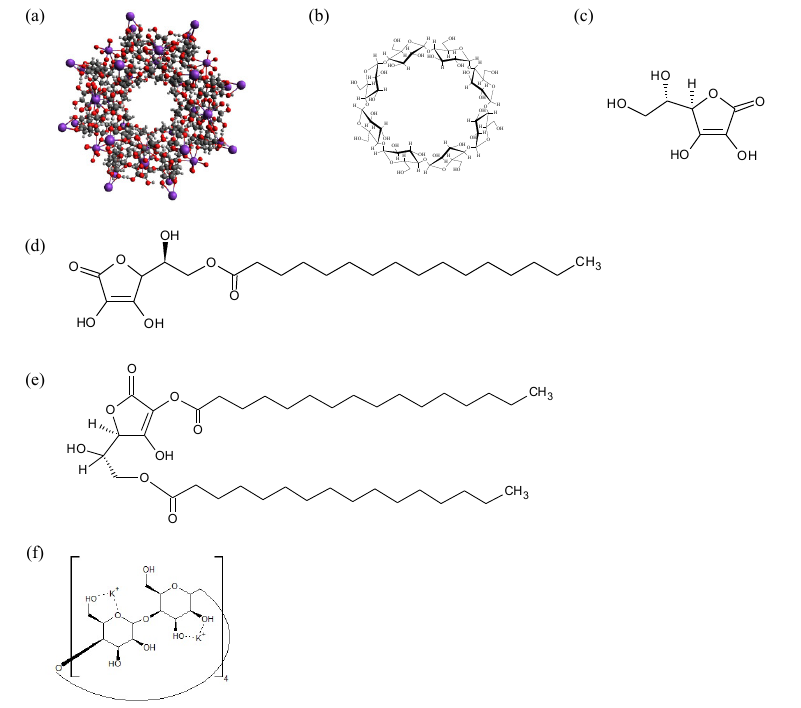
Figure 1. Chemical structures of: ( a ) CD-MOF-1; ( b ) γ -CD; ( c ) ASC; ( d ) ASCP; ( e ) ASCDP; ( f ) γ -CD(KOH) 2.